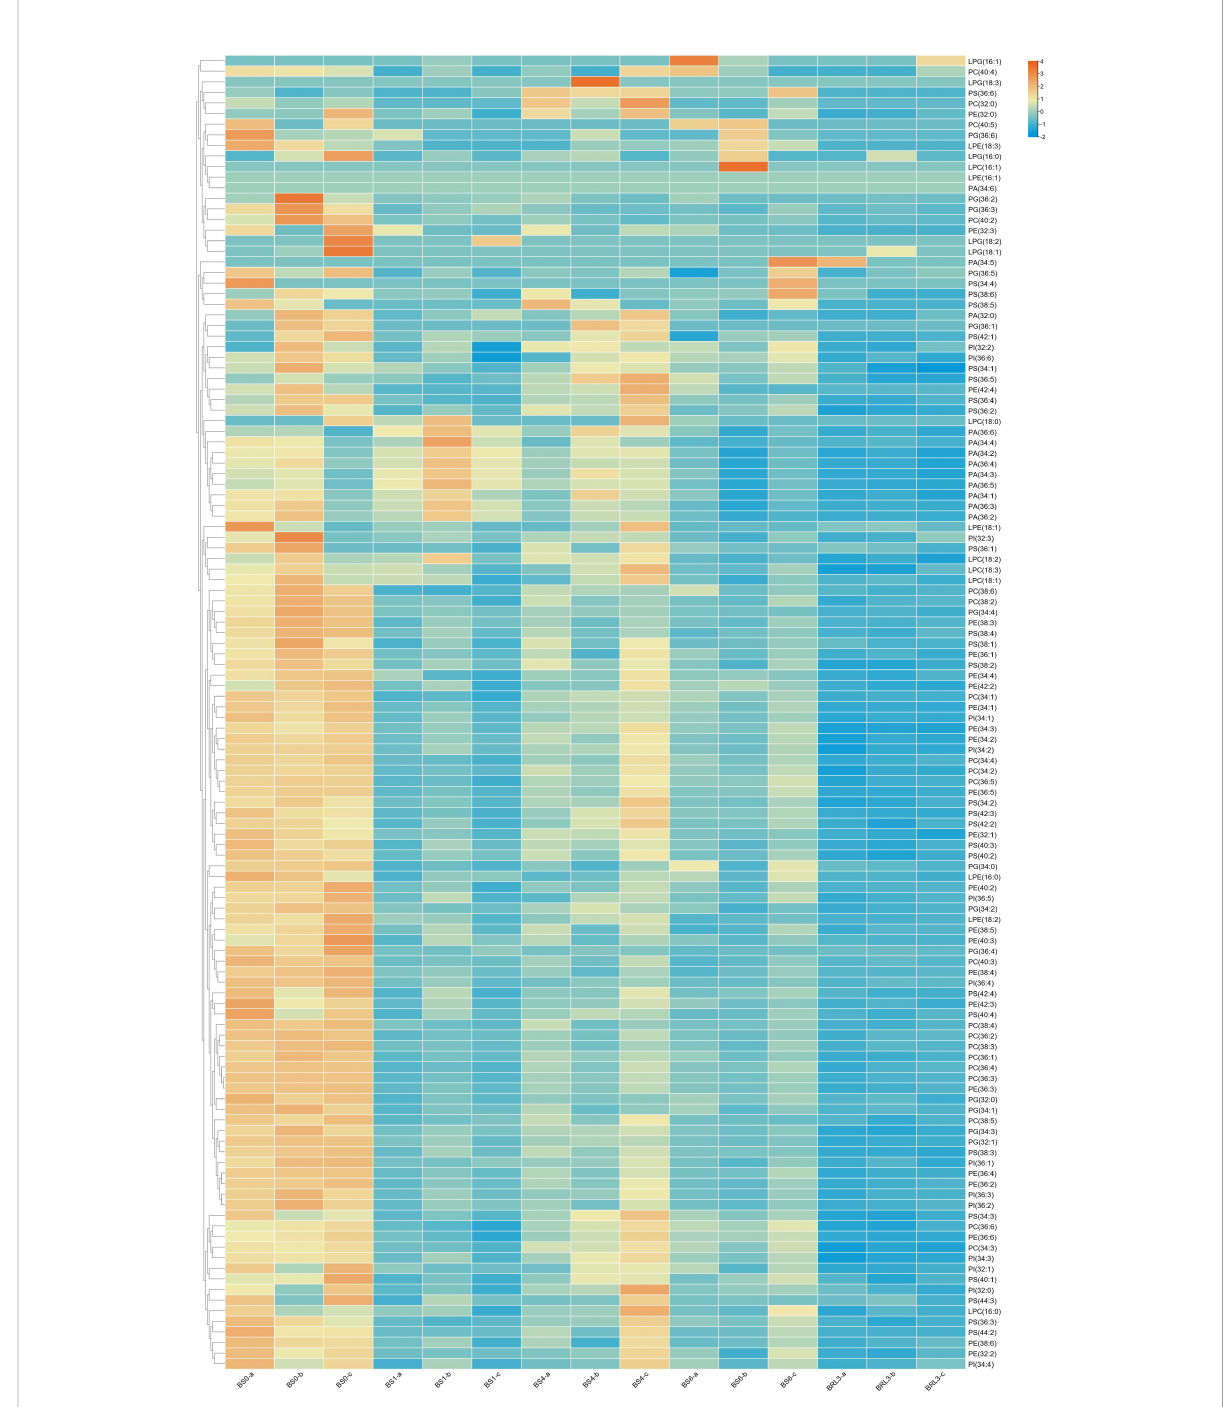
FIGURE 5 Heatmap of the changes in glycerophospholipid and lysophospholipid contents in BJG after shading and light recovery treatments. Each colored cell on the map corresponds to the content of a different lipid species. Orange color indicates a high content, and blue color indicates a low